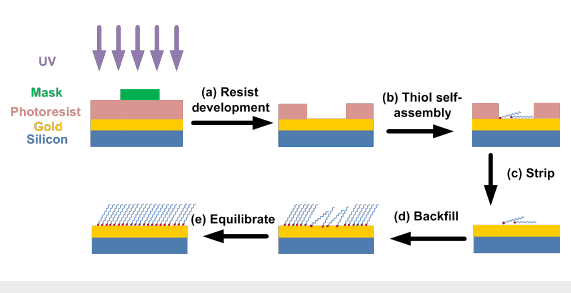
Figure 6: Schematic of the photolithography process for EG 3 -thiol pattern deposition. (a) A micropatterned gold surface, covered with a negative tone resist, is patterned by exposure to UV light through a photomask. (b) Self-assembly of EG 3 thiols at low concentration generates low-grafting-density patterns. (c) Residual negative resist is stripped off by solvent washing. (d) Newly exposed gold surface is covered by high-grafting-density EG 3 thiol by backfilling. (e) Overnight exposure to EG 3 solution equilibrates the patterned-thiol SAM to a uniform